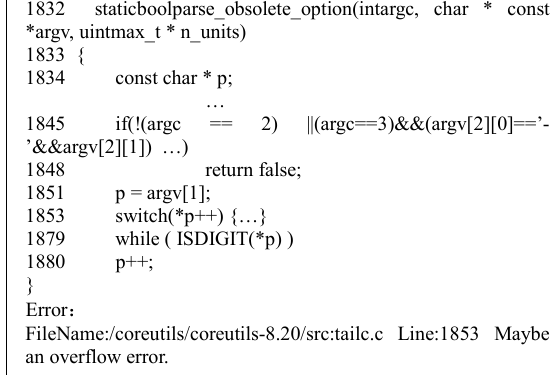
Figure 8 A bug in tail.c found by